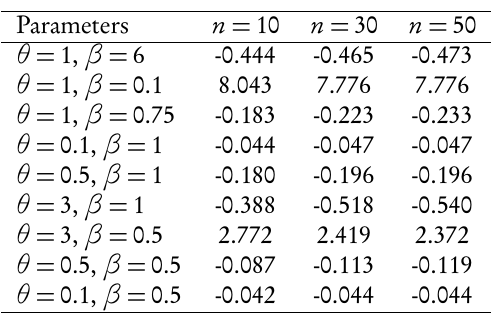
Biases of (cid:98) θ